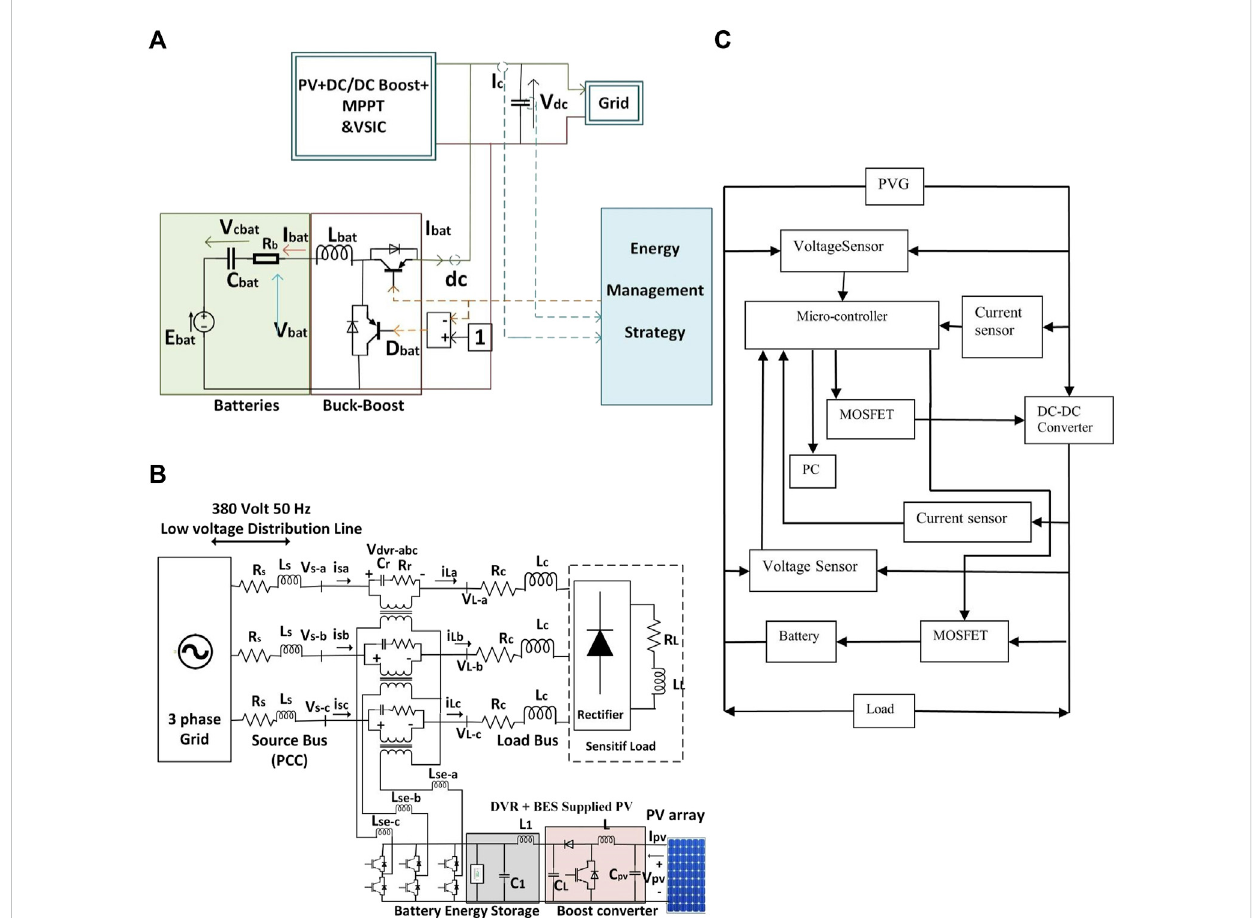
FIGURE 7 PV-Battertopology diagram for (A) a control managementalgorithm on theDC/DC side using VSIC as a charge controller for thestability ofthe grid parameter (Marhraoui et al., 2020b). (B) MPPT-based FS and MPPT-FM methods connected to 3-phase three-wire distribution network (Kiswantono et al., 2019). (C) P&O-based MPPT triggered by PWM system (Situmorang et al.,